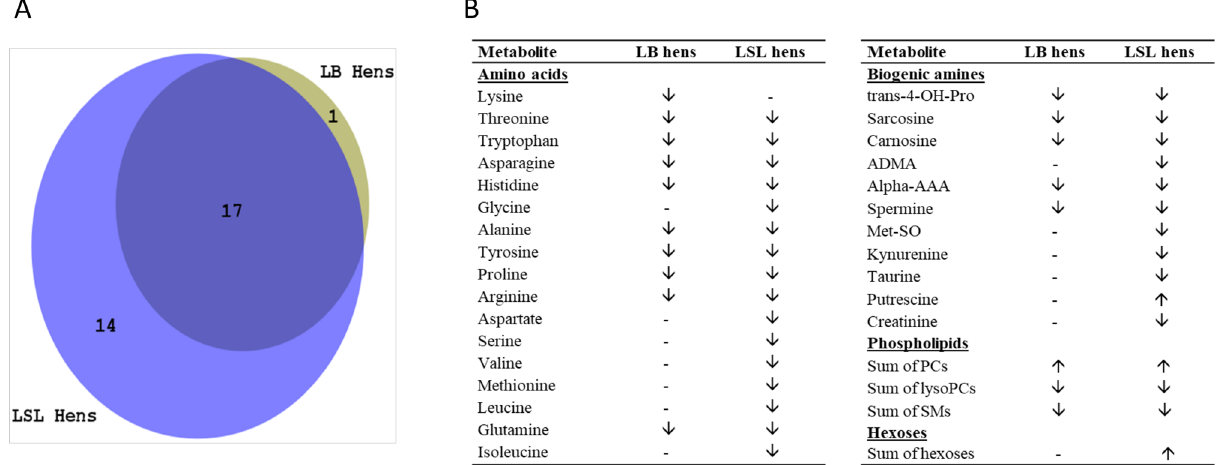
Figure 3. ( A ) Venn diagram indicating the number of plasma metabolites expressed differently between 16 and 24 weeks old LB (olive) and LSL (navy) hens. ( B ) List of the metabolites depicted in the Venn diagram. The symbols “ ↑ ” and “ ↓ ” indicate that metabolite expression increased or decreased at week 24 in comparison to week 16. Symbol “–” indicates this metabolite did not vary in one strain. Differences were revealed by FDR adjusted p-value from t-student’s test (< 0.05). ADMA asymmetric dimethyl arginine, Alpha-AAA alpha